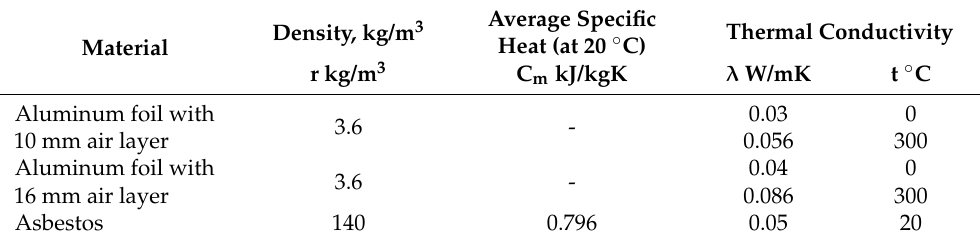
Table 2. Parameters of materials from which the modeled system is built.